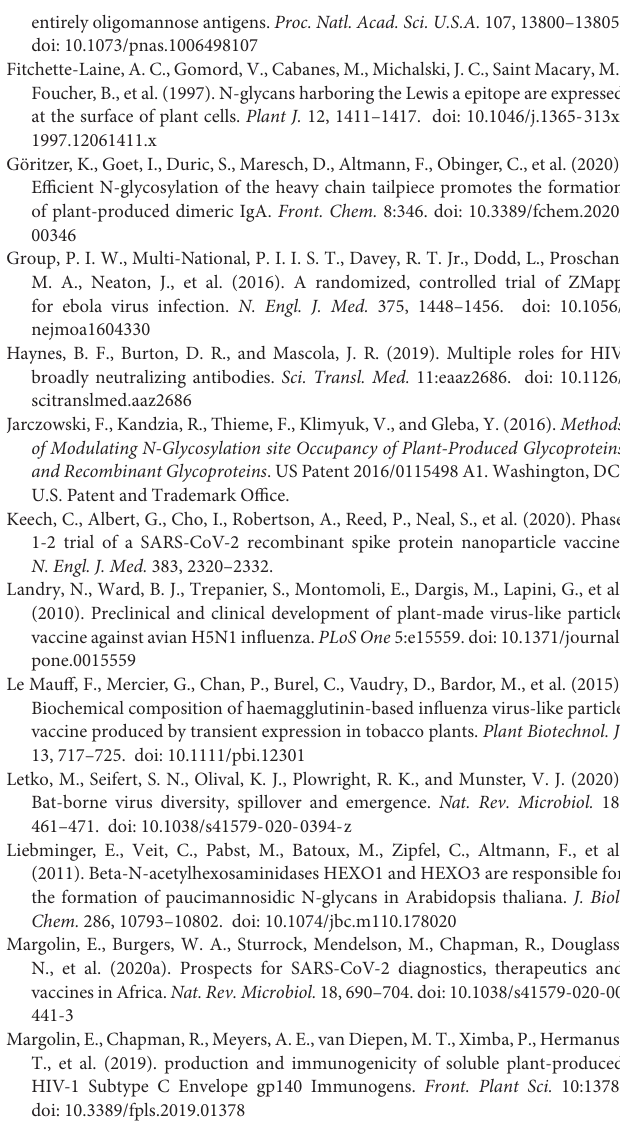
Supplementary Table 1 | Comparison of site-specific glycosylation of HIV Env gp140 NFL when produce in plants or mammalian cells. The glycosylation profile of the recombinant protein is shown when the protein was expressed in N. benthamiana (A) and HEK293 cells (B) . The change in glycosylation that occurs when the protein is produced in plants is shown in (C) . Supplementary Table 2 | Comparison of MARV GP (cid:49) TM glycosylation when the protein was expressed in plants and mammalian cells. The glycosylation of the glycoprotein is shown when the protein was expressed in N. benthamiana (A) and in HEK293 cells (B) . The change in glycosylation that occurs when the protein was produced in N. benthamiana is shown in (C) . (m5-m12 = high-mannose, pauci = paucimannosidic). In each cases the numbers on X axis of the Figure indicate the position of a putative N-glycan sequon. (m5-m12 = high-mannose, pauci = paucimannosidic). In each case the number above the tables indicates the position of a putative N-glycan sequon. Numbers in the table indicate the relative proportion of each glycoforms at this site. The table to the right summarizes the relative abundance of each glycan species considering all the individual sites